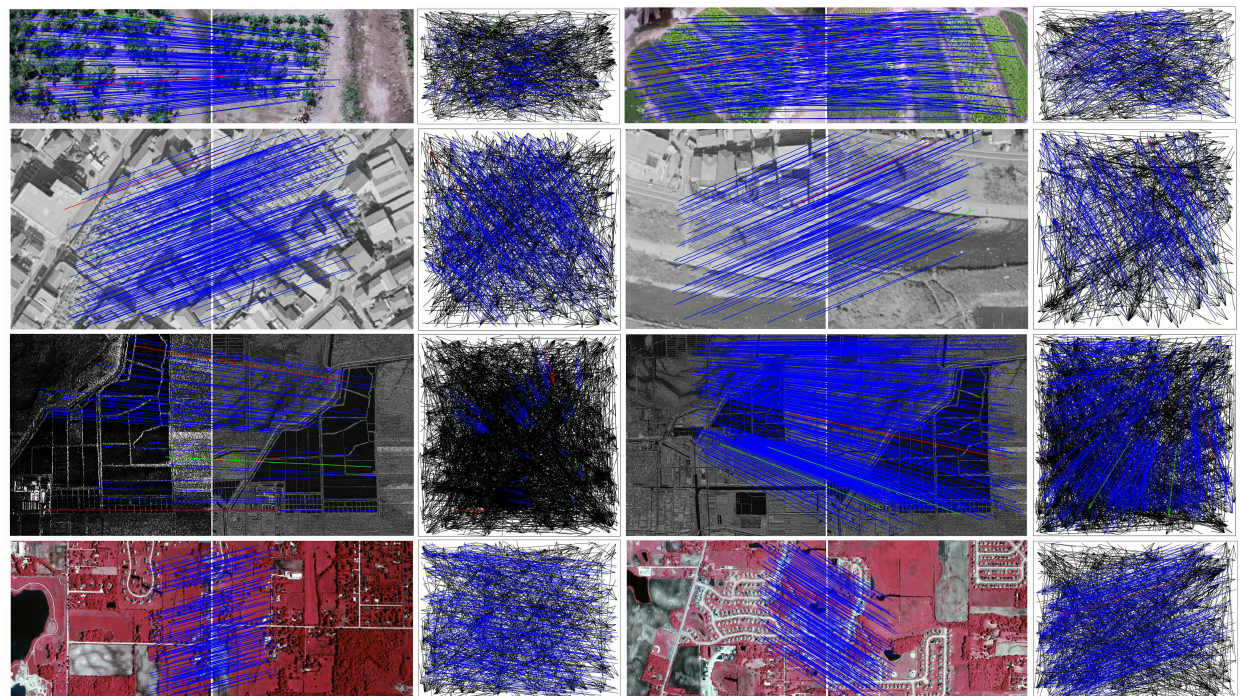
Figure 7. Qualitative matching results of our TAT on some typical image pairs from the four test datasets, such as UAV ( first row ), PAN ( second row ), SAR ( third row ), and CIAP ( fourth row ). The initial inlier percentages on the eight image pairs (from top to bottom, left to right) are 30.12%, 26.73%, 27.65%, 26.41%, 10.57%, 13.19%, 15.24%, and 11.64%. The head and tail of each arrow in the motion field correspond to the positions of the corresponding feature points in the two images (blue = true positive, black = true negative, green = false negative, and red = false positive). For visibility, in the image pairs, only no more than 150 randomly selected matches are presented, and the true negatives are not shown. Best viewed in